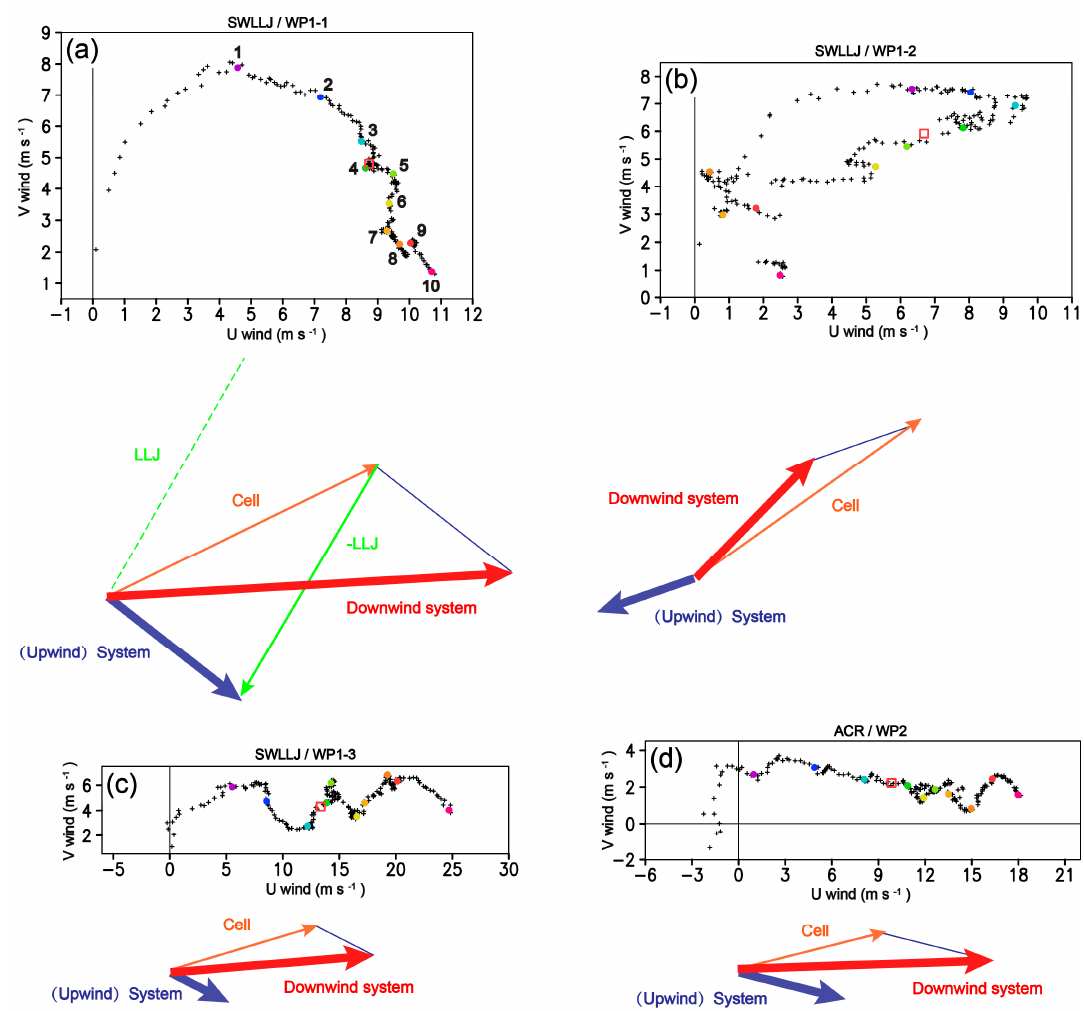
Figure 11. Composite hodographs of the radiosonde station “station1” in Figure 10 under the vertical wind profiles of ( a ) WP1-1, ( b ) WP1-2, and ( c ) WP1-3 in the SWLLJ situation and ( d ) under the vertical wind profile of WP2 in the ACR situation. The numbers on the hodographs and the vectors below the hodographs indicate heights (km) and motion vectors for the convective cells, upwind system, and downwind system, respectively. The open rectangles indicate the mean wind vector between 1.5 km (about 850 hPa) and 7 km (about 300 hPa). Storm motion analysis following Corfidi et al. [74] and Corfidi [73] is also shown; the LLJ vectors are only given in ( a